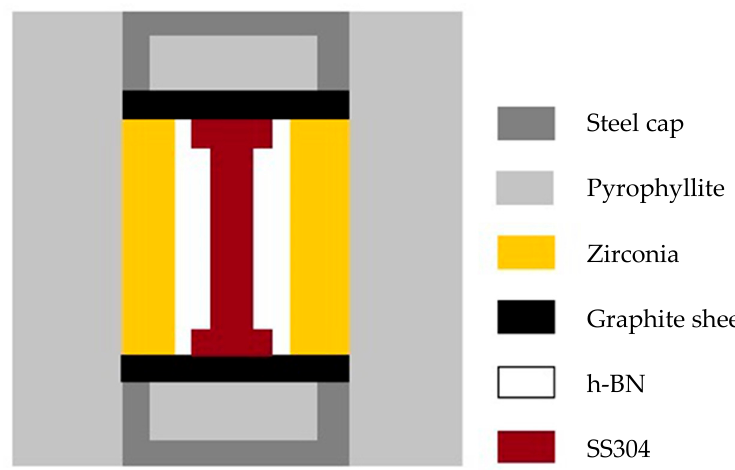
Figure 1. Sketch map of the PQ sample assembly.